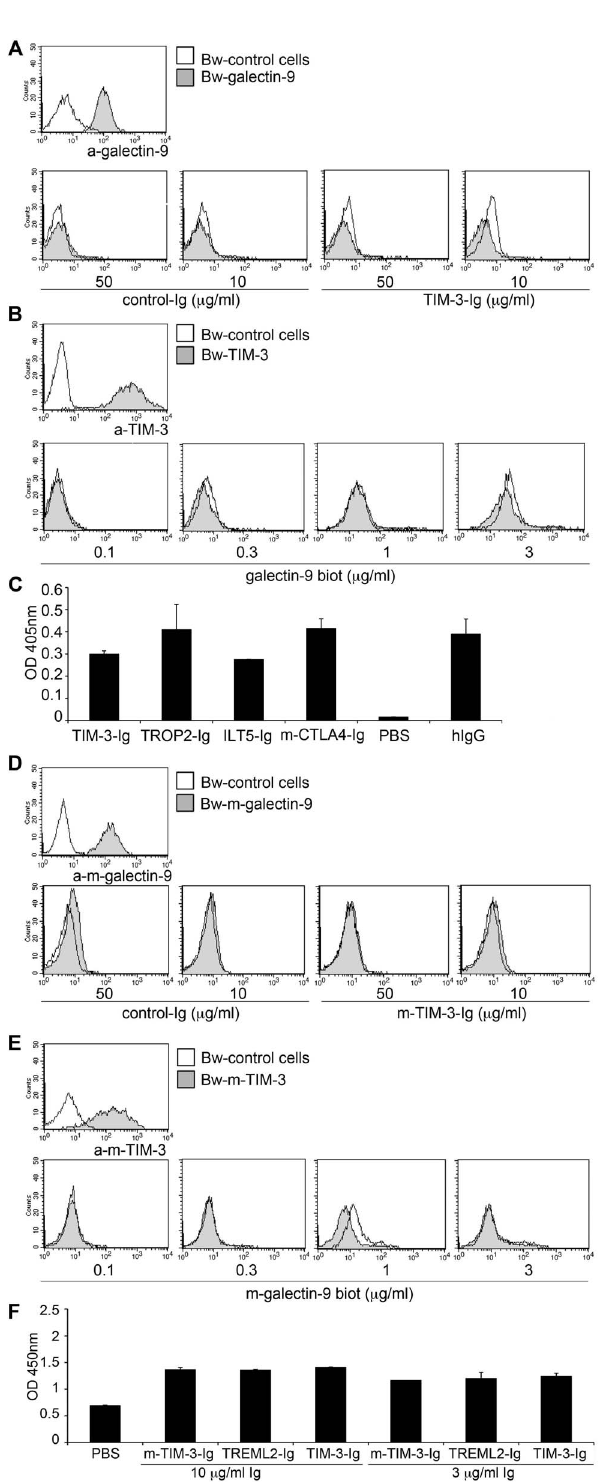
Figure 2. TIM-3 does not interact with galectin-9. A, D) Bw control cells (open histograms) or Bw cells transduced to express human (A) or murine (D) galectin-9 (grey histograms) were probed with galectin-9 antibodies or with immunoglobulin fusion proteins repre- senting human TIM-3 (TIM3-Ig; A) or murine TIM-3 (m-TIM-3-Ig; D) or a control fusion protein (B7-H3-Ig). Bound antibodies were detected with PE-labelled donkey-anti-goat antibodies. Immunoglobulin fusion pro- teins were detected with PE-labelled goat antibodies to the Fc-part of human IgG. B, E) Bw control cells (open histogram) or Bw